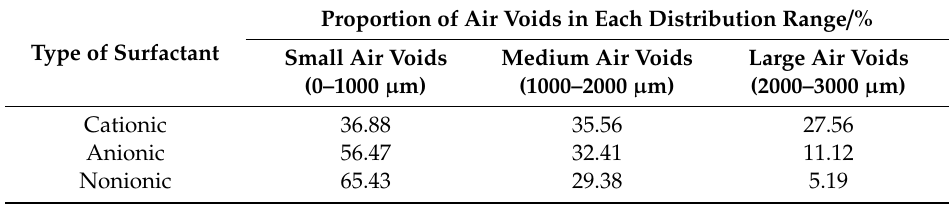
Table 1. Summarization of the e ff ect of the type of surfactants on the air void